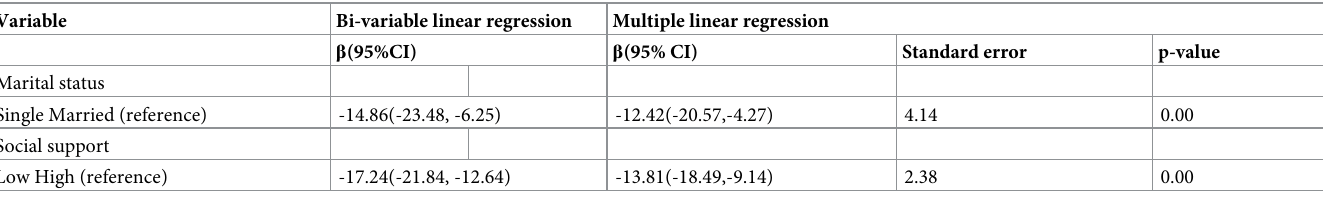
Table 7. Multivariable linear regression model on factors associated with social domain of HRQoL among adult hypertensive patients on treatment at public health facilities in Dessie City Administration, Northeast Ethiopia, 2021 (n =